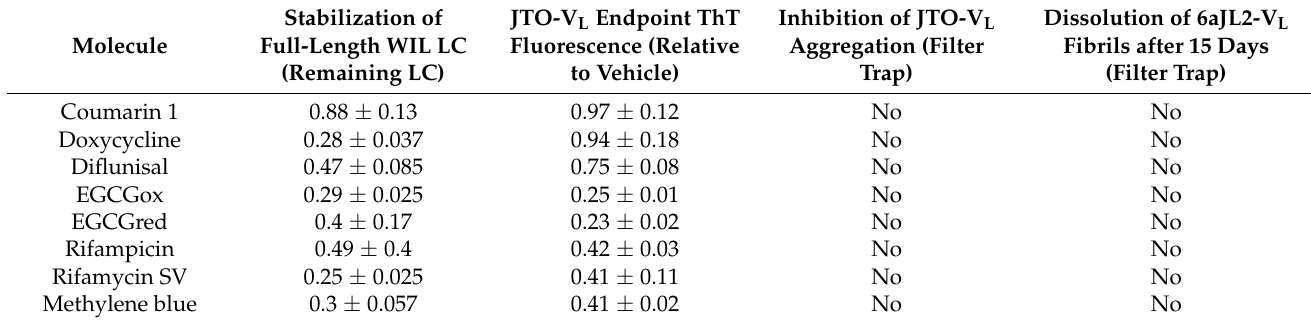
Table 2. Summary of results. Values represent mean ± standard deviation, n = 3 replicates. EGCGox and EGCGred refer to pre-oxidized and freshly thawed EGCG,